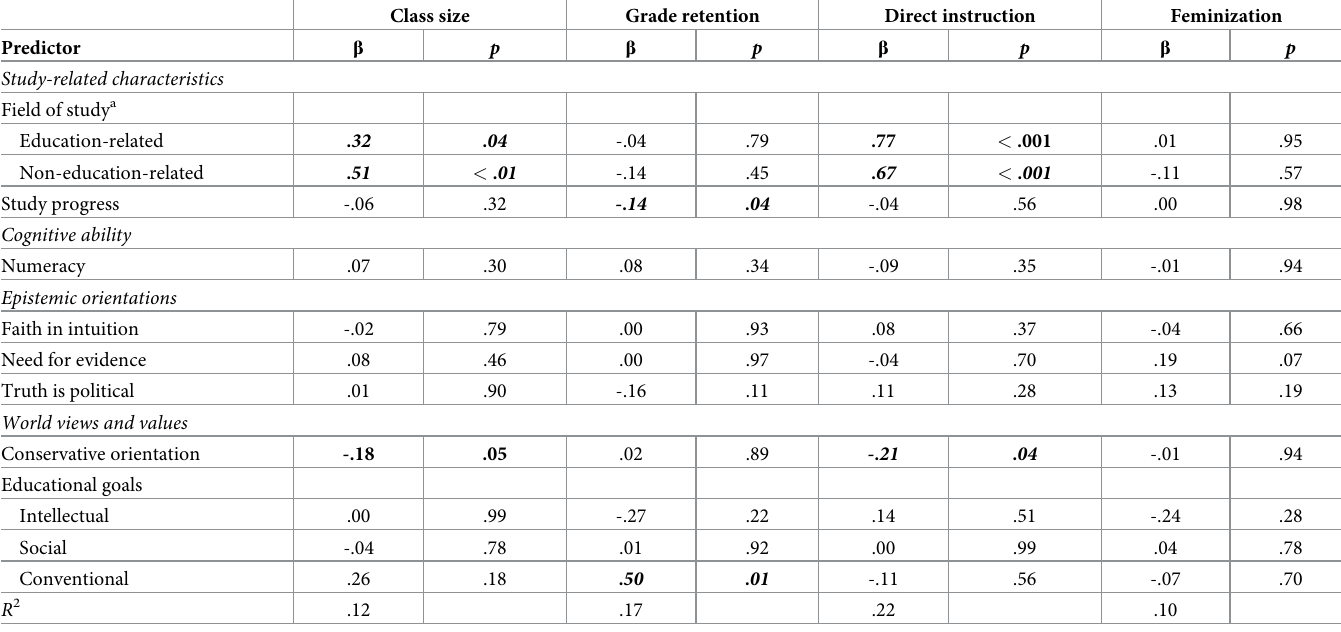
Table 3. Standardized regression estimates from the structural equation models of educational misconceptions. Class